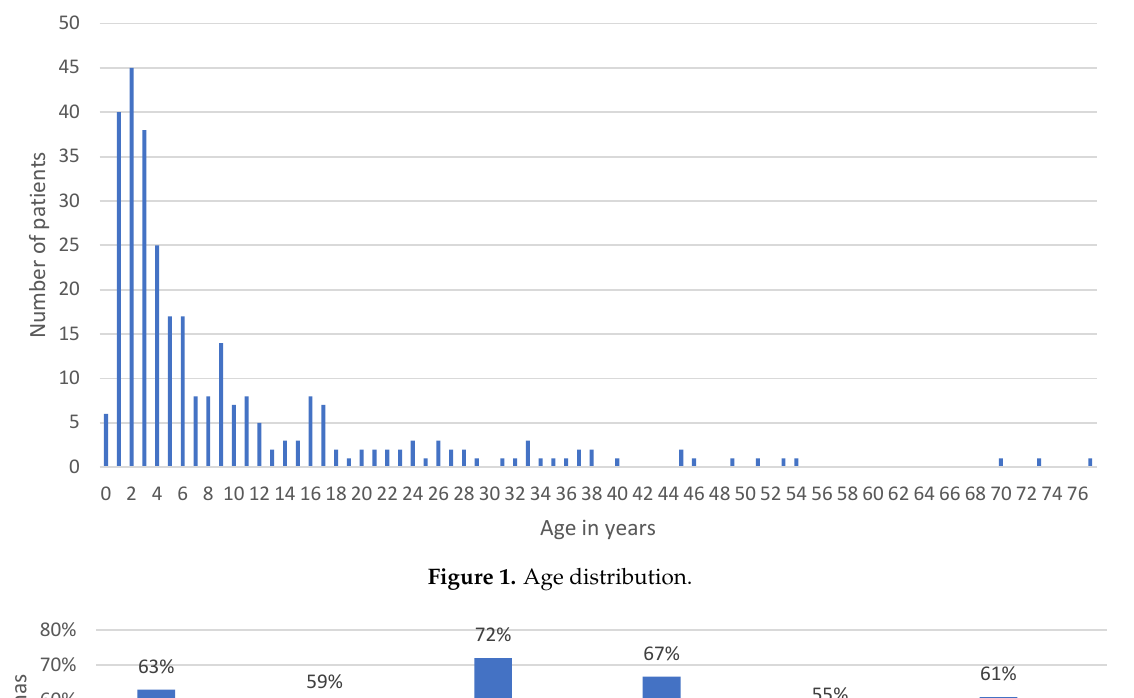
Figure 1. Age distribution. Male/female ratio is 1.6:1. In all age groups, male patients were more commonly af ‐ fected (Figure 2).